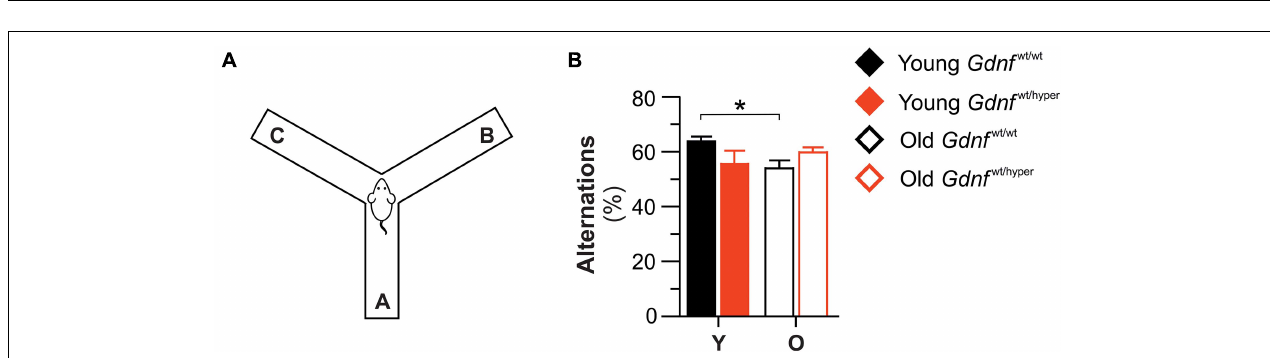
FIGURE 5 | Gene expression of the key cholinergic enzyme, Chat strongly correlates with the expression of the related genes. Graphs (A–C) show correlations in the cortex, and (D–F) show the correlations in the striatum. Cortex: n = 6 (young Gdnf wt / wt ), n = 5 (old Gdnf wt / wt ), n = 7 (young Gdnf wt / hyper ), n = 6 (old Gdnf wt / hyper ). Striatum: n = 5 (young Gdnf wt / wt ), n = 6 (old Gdnf wt / wt ), n = 6 (young Gdnf wt / hyper ), n = 7 (old Gdnf wt / hyper ). Ache , acetylcholinesterase; Chat , choline acetyltransferase; Cht , choline transporter; M3 mAChR , m3 muscarinic ACh receptor 3; Trka , tropomyosin receptor kinase A.